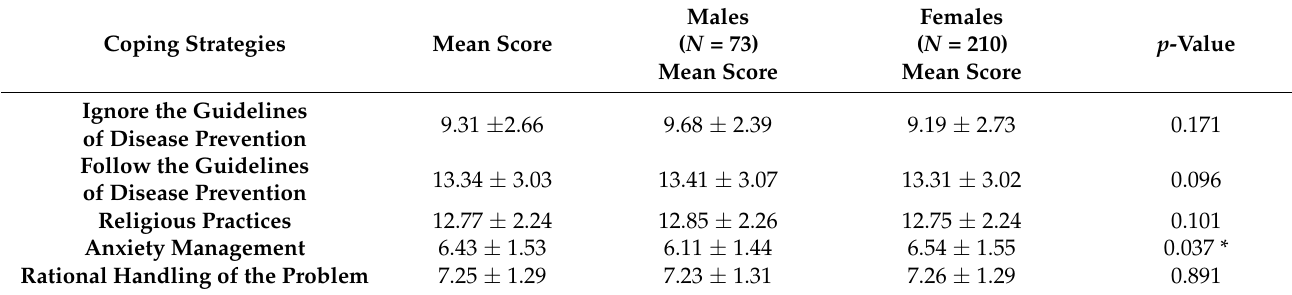
Table 4. Coping strategies of males and females in the Egyptian population. A coping strategies questionnaire was used to identify coping strategies in the population. Respondents were given a score for each strategy based on their answers to the questionnaire. Data are expressed as mean ± SD, and an independent sample t -test was used to compare coping strategies between males ( N = 73) and females ( N = 210). Asterisk (*) indicates significant difference ( p = 0.037).